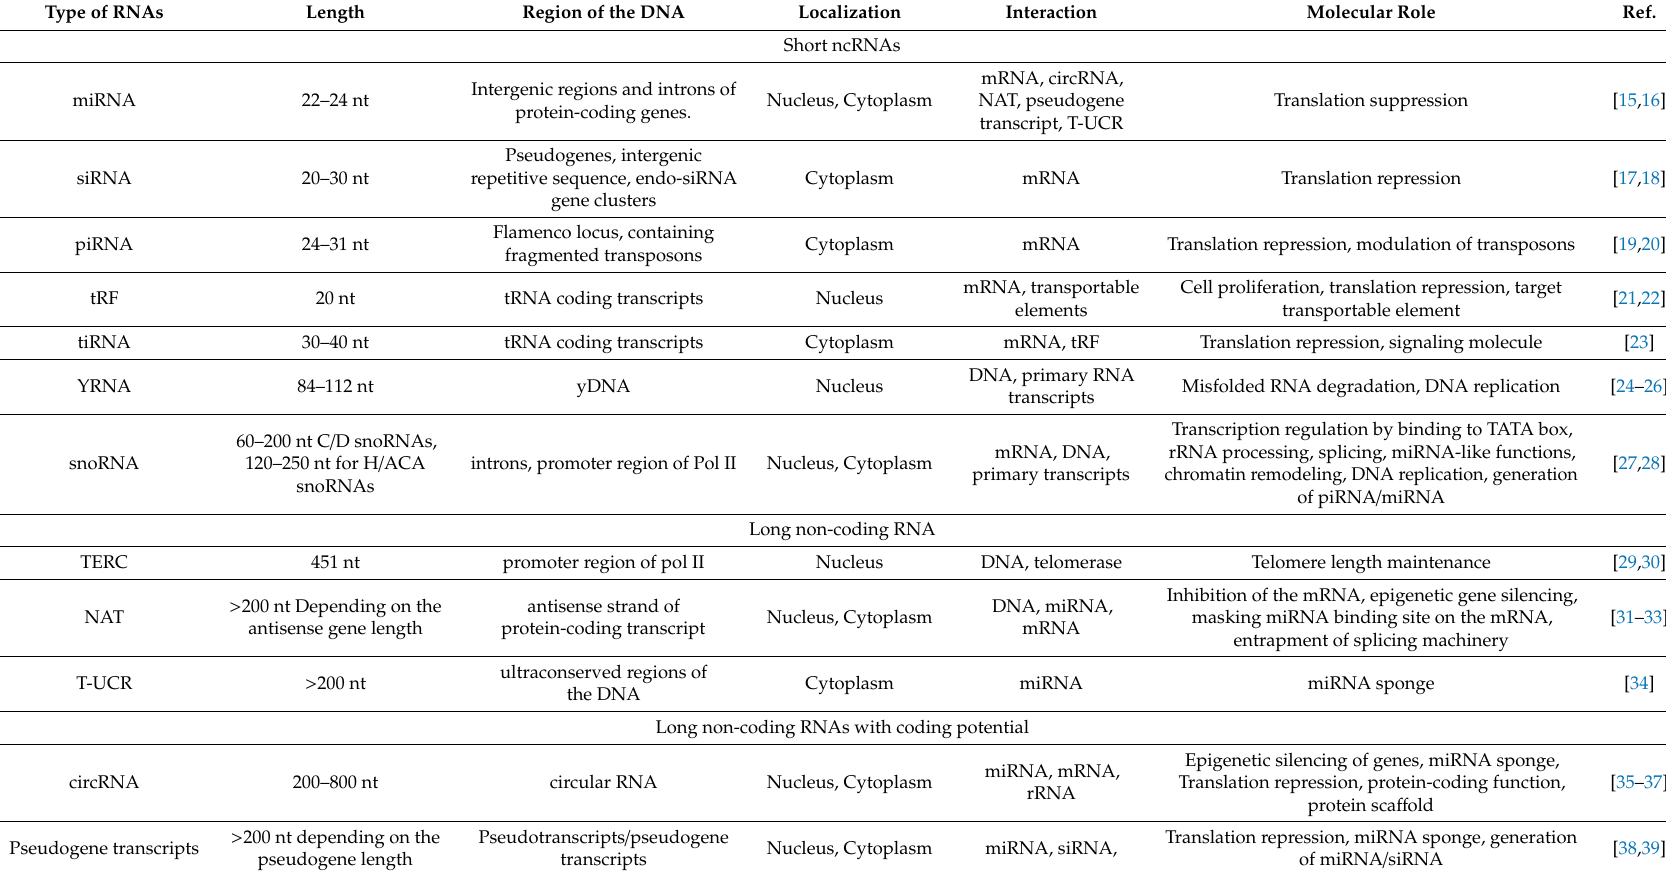
Table 1. The main types of non-coding RNAs and their related